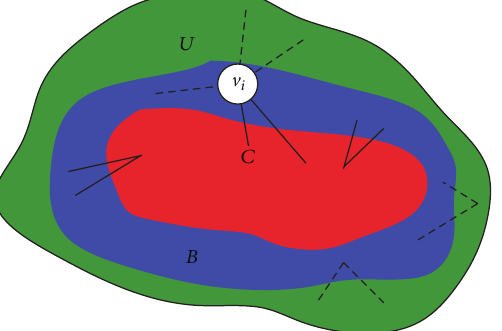
Figure 2: Illustration for the local search.